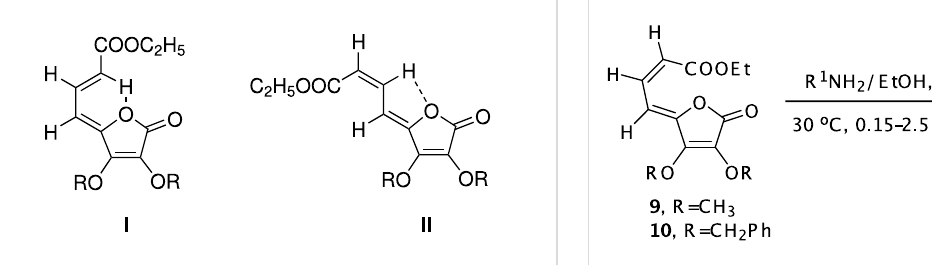
decided on the basis of 1 H NMR spectroscopic data (Supporting Information File 1) wherein H-7 and H-8 in the major isomer 9 appeared as dd (δ = 7.57) with J = 11.9 Hz each and d, 5.96 ( J = 11.9 Hz, H-7). The analogous protons in the minor isomer 9a appeared as a dd δ = 7.0 ( J = 11.3 Hz, 11.4 Hz, H-7) and δ = 7.27 (d, J = 11.1 Hz, 1H, H-8) respectively indicating the Z and E relationship of H-7 with H-8 in the above two isomers. The 1 H NMR spectra of the ZZ and ZE isomers were similar to those reported earlier [37] and the chemical shifts of H-6 and H-8 were almost similar in the major isomer 9 in spite of the close proximity of H-8 with the carbethoxy group. The low chemical shift of H-8 in